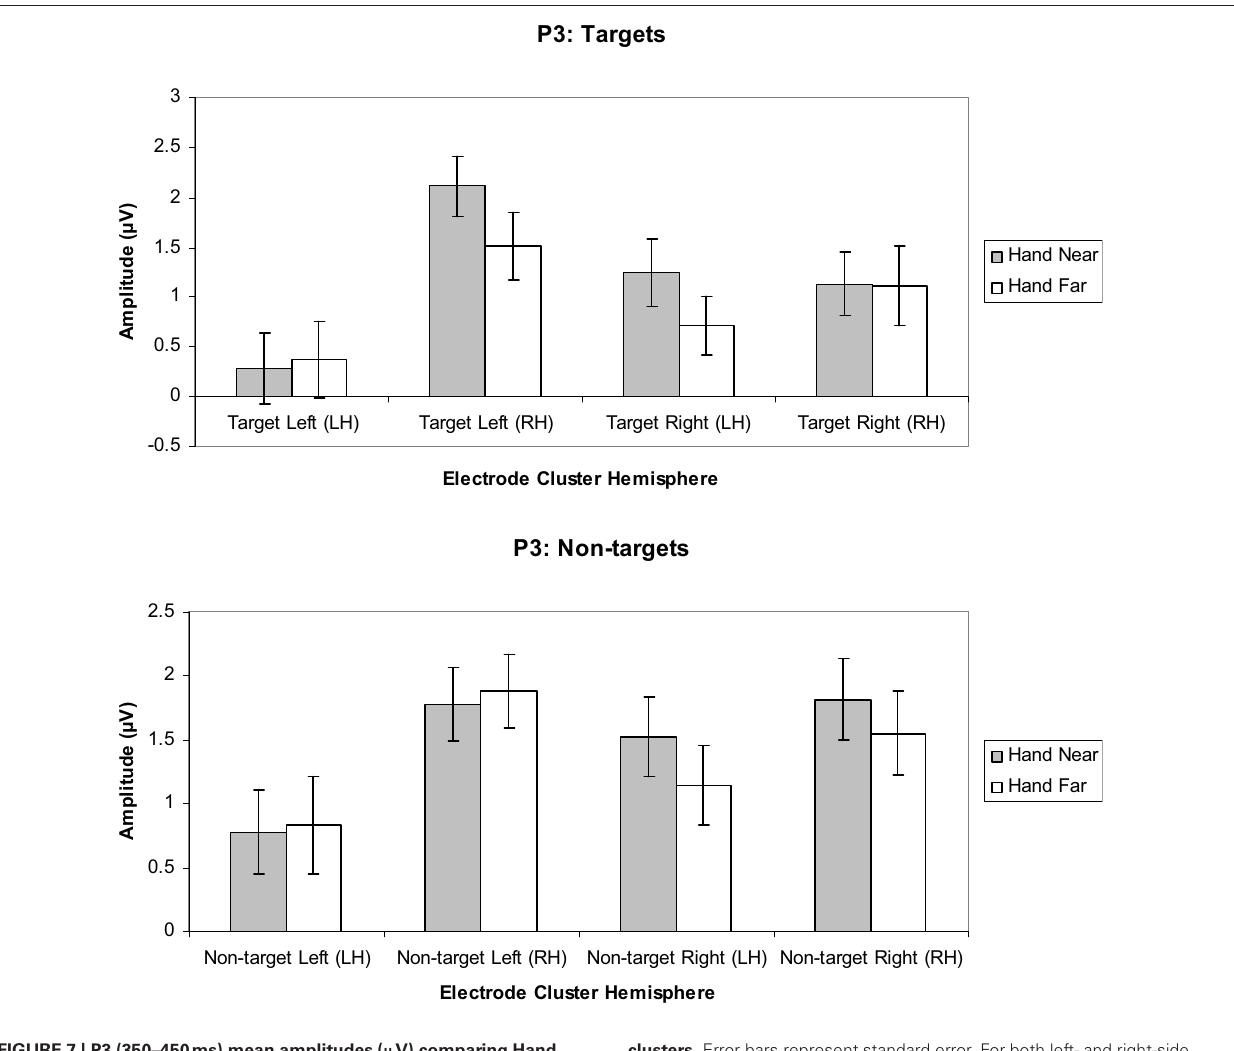
clusters. Error bars represent standard error. For both left- and right-side targets, P3 amplitudes for the Near condition were larger relative to the Far condition in the contralateral